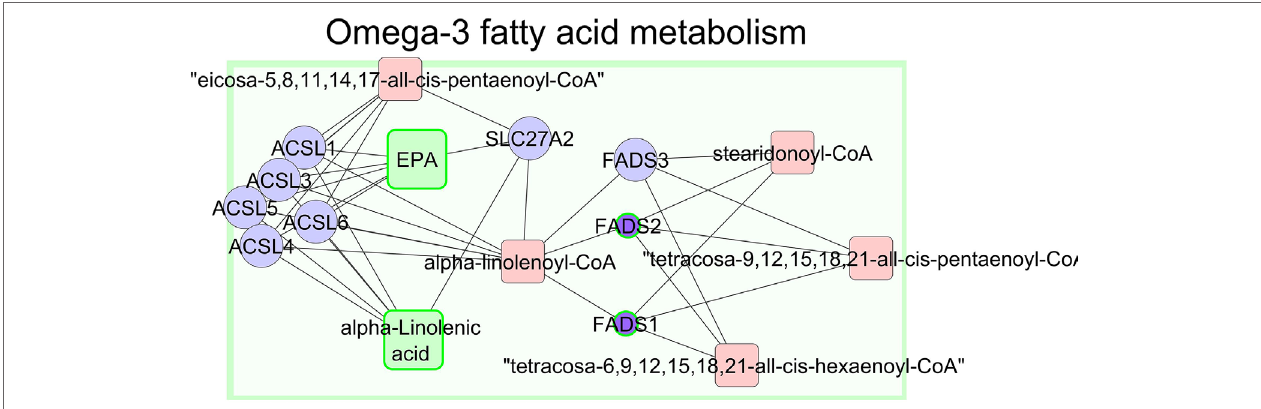
FiGURE 6 | The network of metabolites and genes involved in omega-3 fatty acid metabolism in ALF lambs. Significant metabolites with experimental data are shown in green squares, and significant genes with experimental data are shown in purple circles with green borders. The size of the nodes represents the direction of the change. A small purple circle with a green border indicates downregulated genes, and large green square nodes point to upregulated